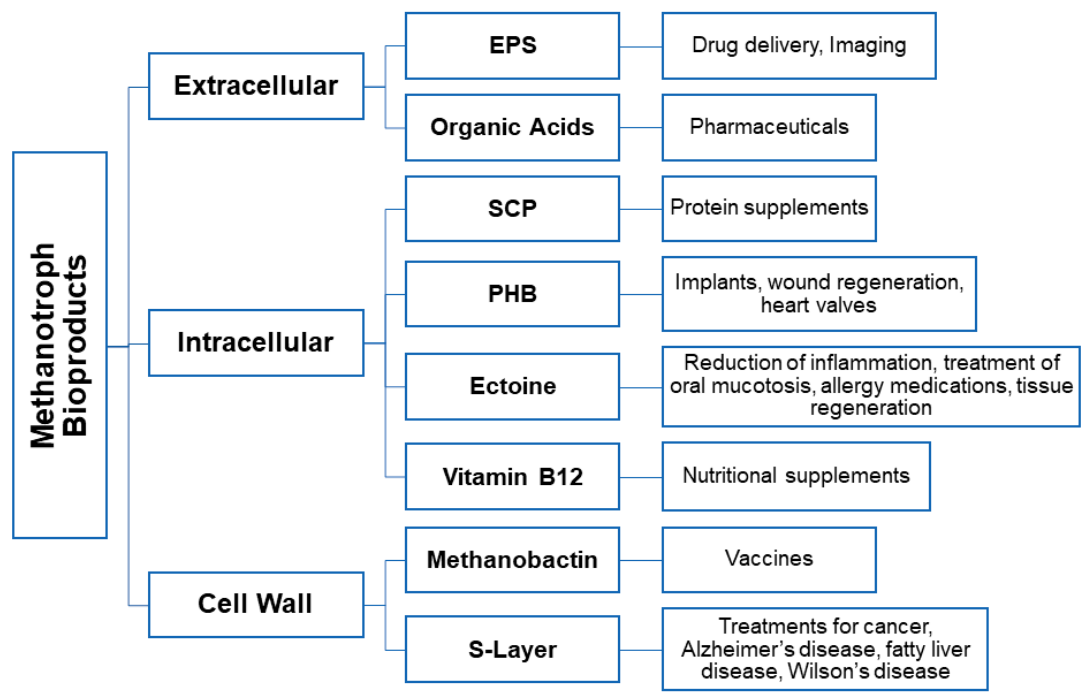
Figure 3. The diverse potential bioproducts synthesized by methanotrophs and their biomedical